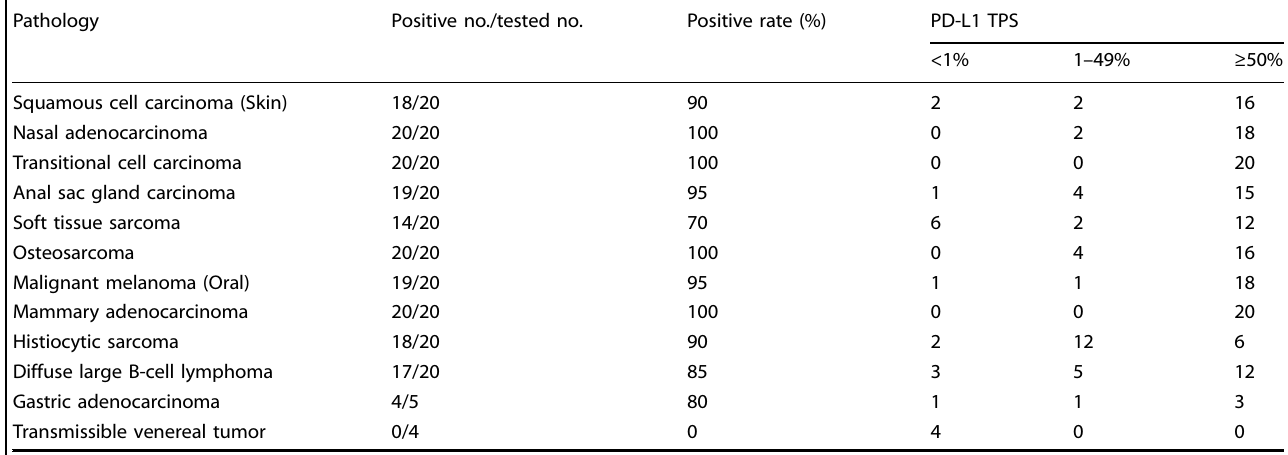
Table 1. PD-L1 expression in various malignant cancers. Pathology Positive no./tested